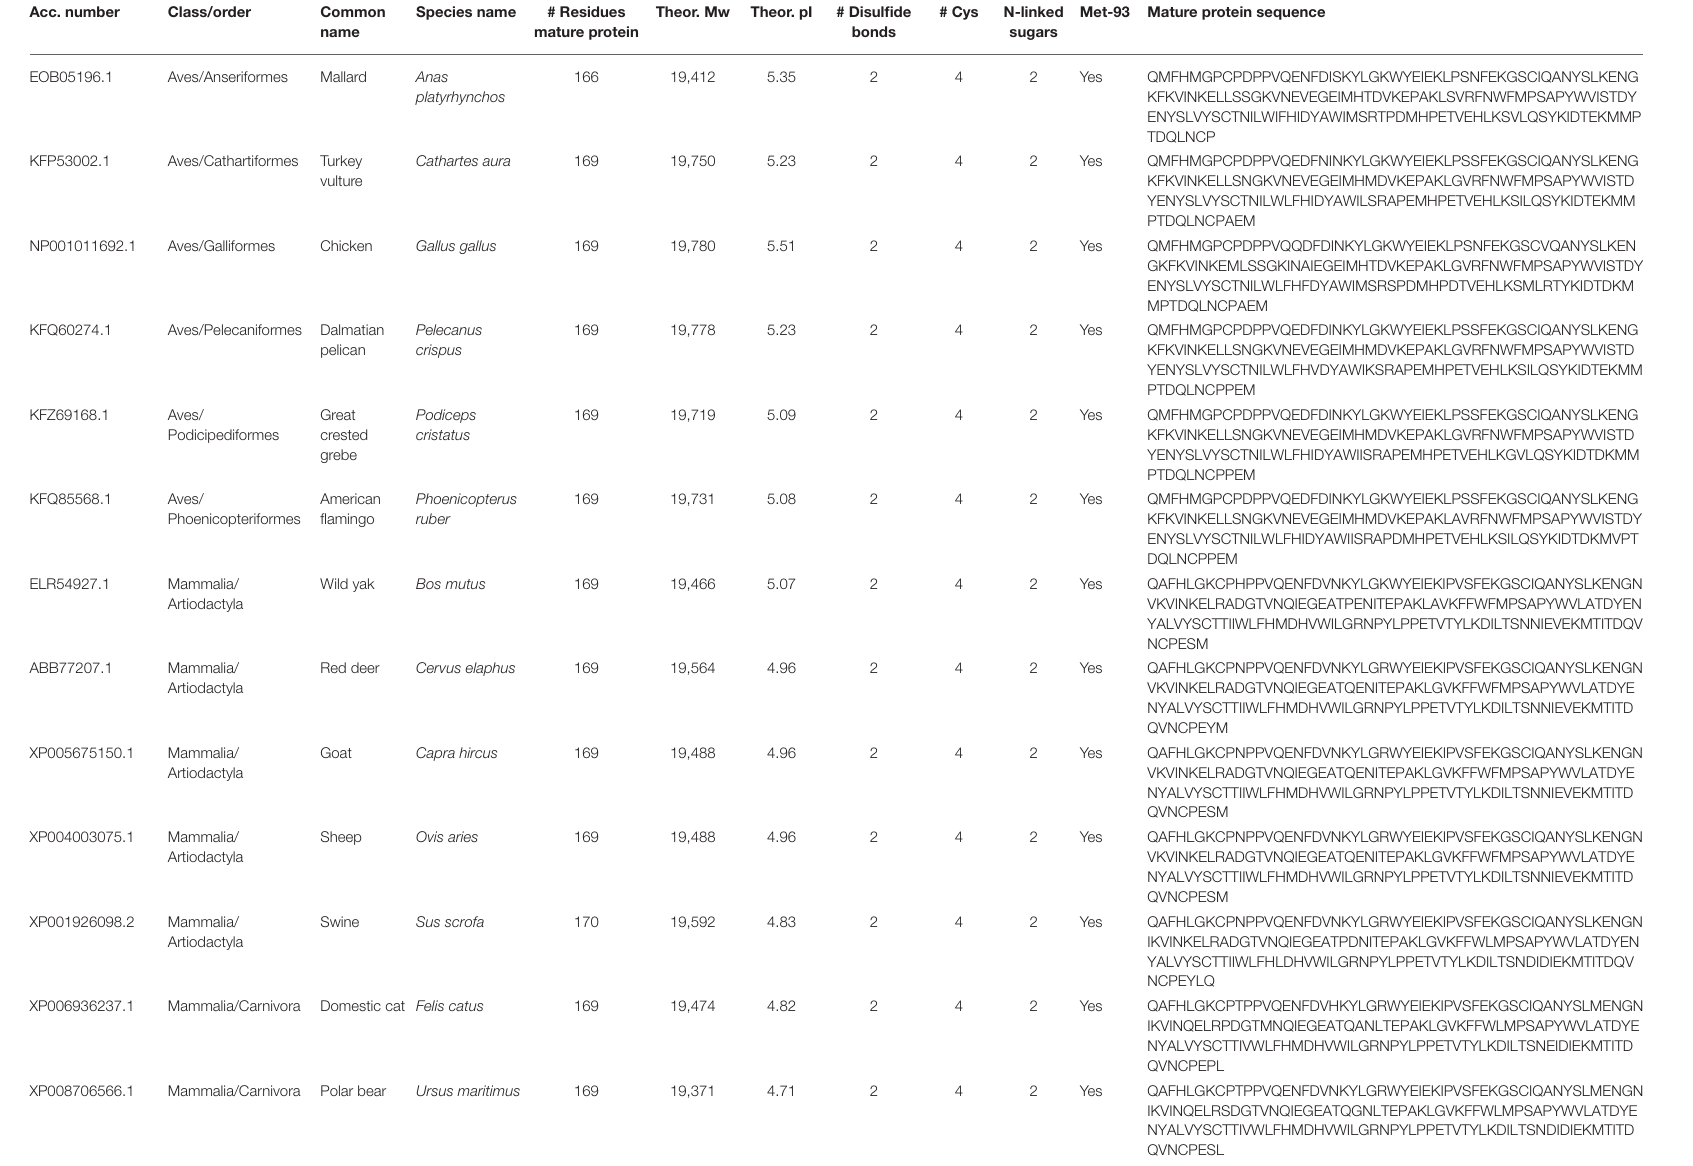
TABLE 1 | ApoD protein parameters. Acc. number Common